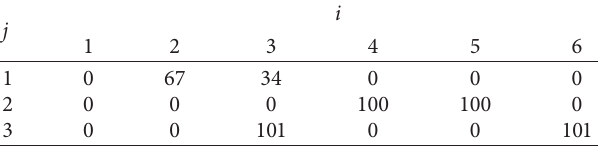
Table 6: Number of empty trucks.